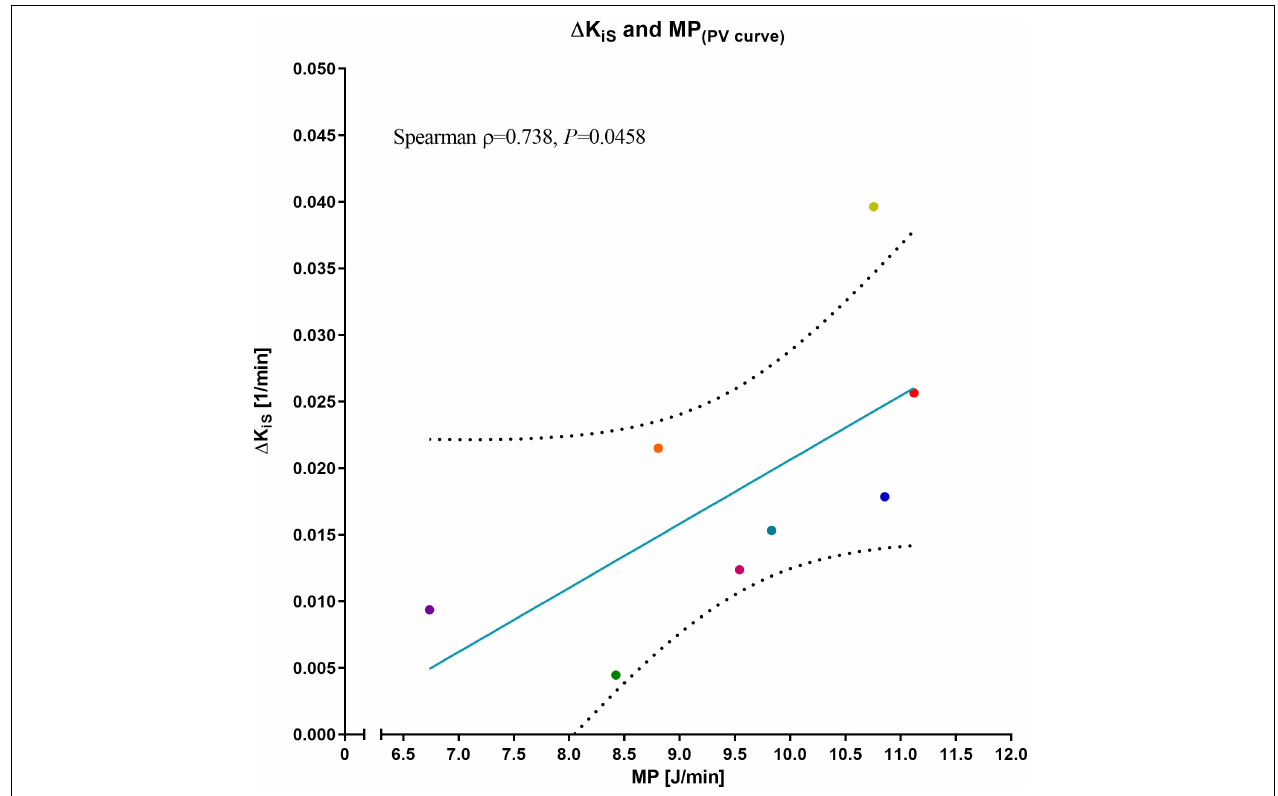
FIGURE 6 | Correlation of (cid:49) K iS and mechanical power. Normalized 18 F-FDG uptake rate, expressed as difference between the two PET/CT scans ( (cid:49) K iS ), and mechanical power (MP) as assessed from the pressure–volume curve; dotted lines: 95 % confidence band of the best-fit line. Correlation was assessed as non-parametric bivariate correlation (Spearman). Colors represent corresponding animals from Figure 3 .